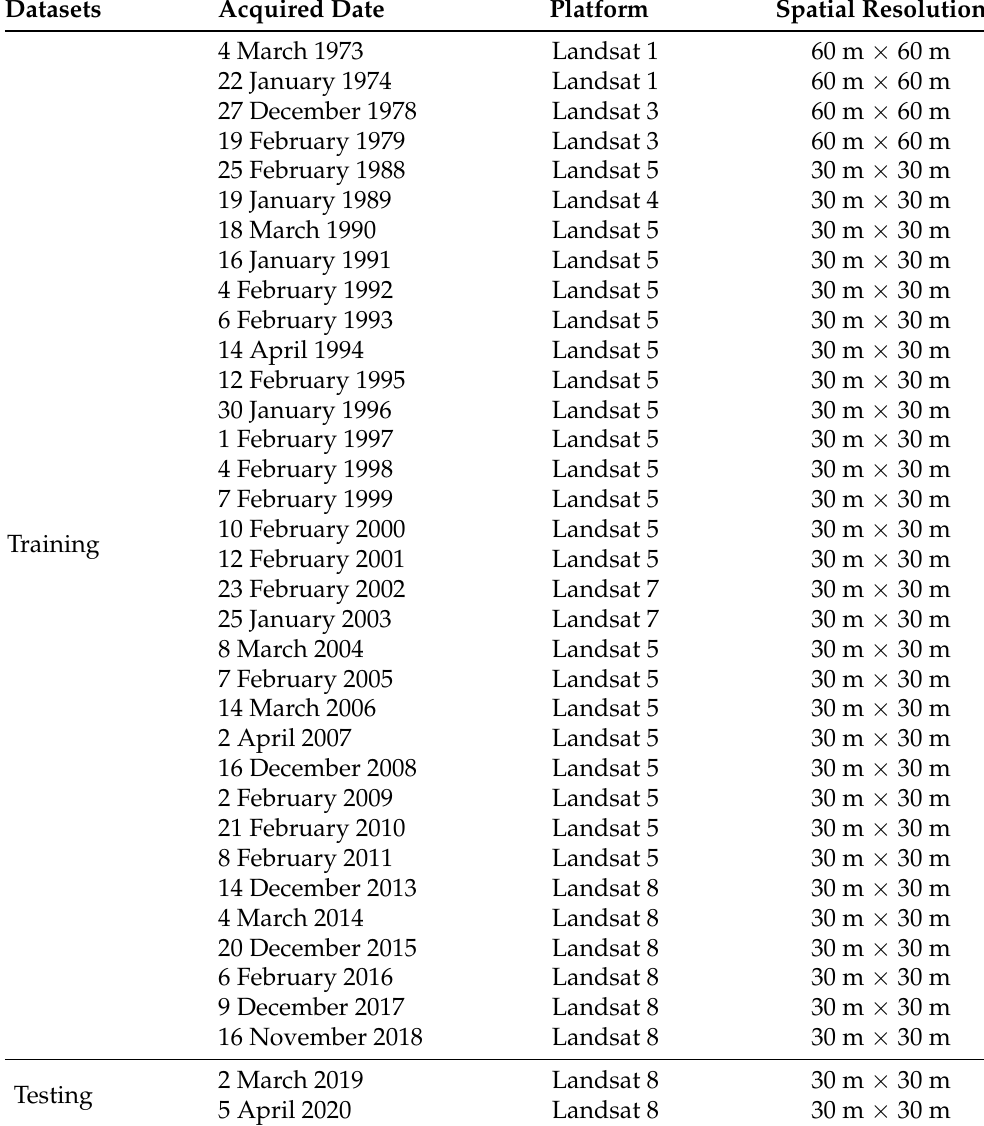
Table 1. Optical remote-sensing images of study area from 1973 to